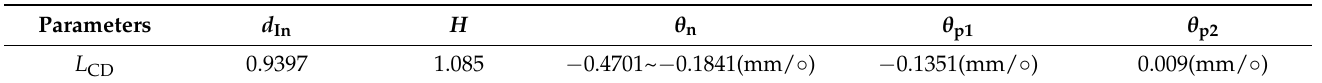
Table 1. Sensitivity of L CD to each parameter.